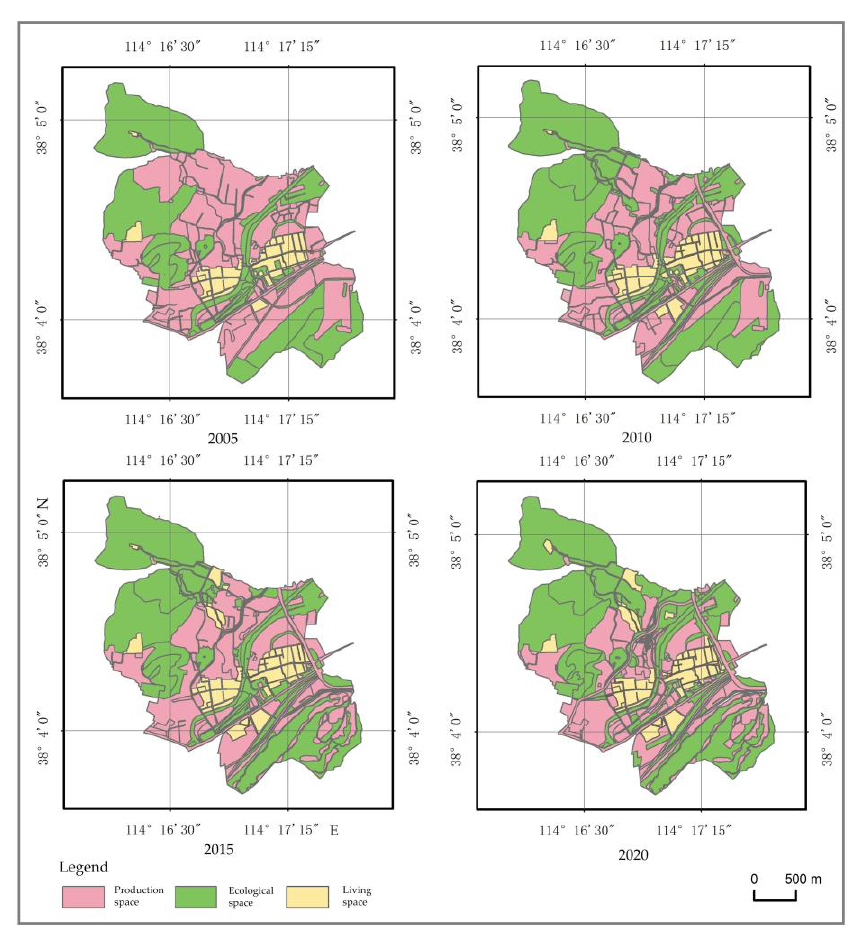
Figure 2. The current land use situation of East Tumen Village and West Tumen Village from 2005 to 2020.